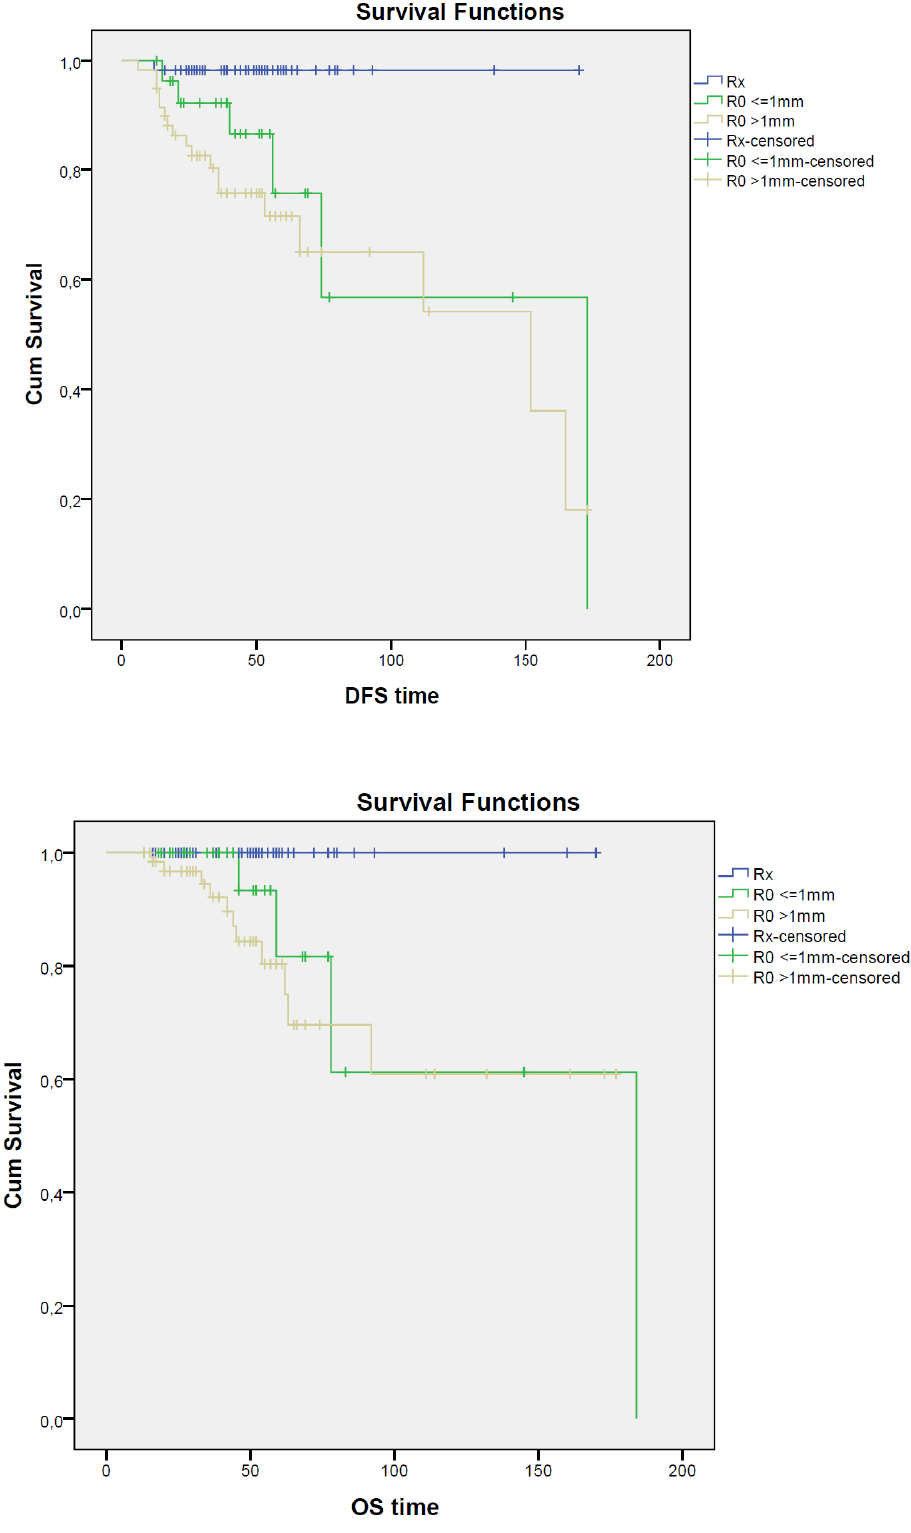
Figure 1. Survival curves for RX, R0 < 1 mm, and R0 > 1 mm groups. Kaplan–Meier curves show LRFS, DFS, and OS for patients with RX (blue solid), ‘R0 < 1 mm (green solid), and ‘R0 > 1 mm (yellow solid) resection; time units: